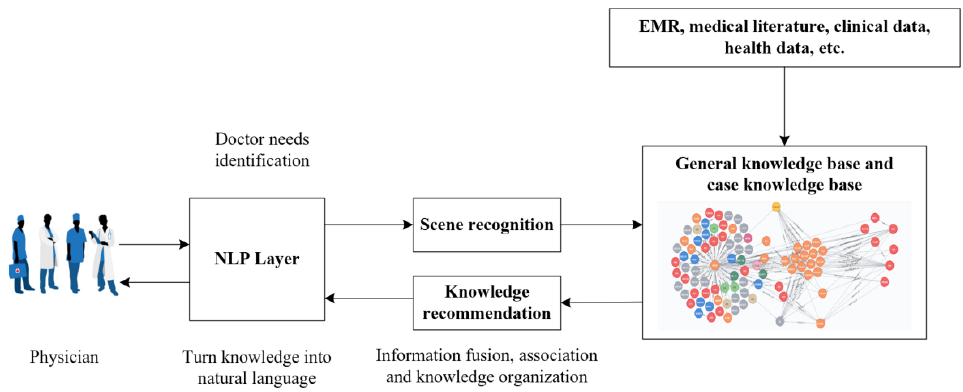
Figure 6. CBR-MKS knowledge recommendation process.